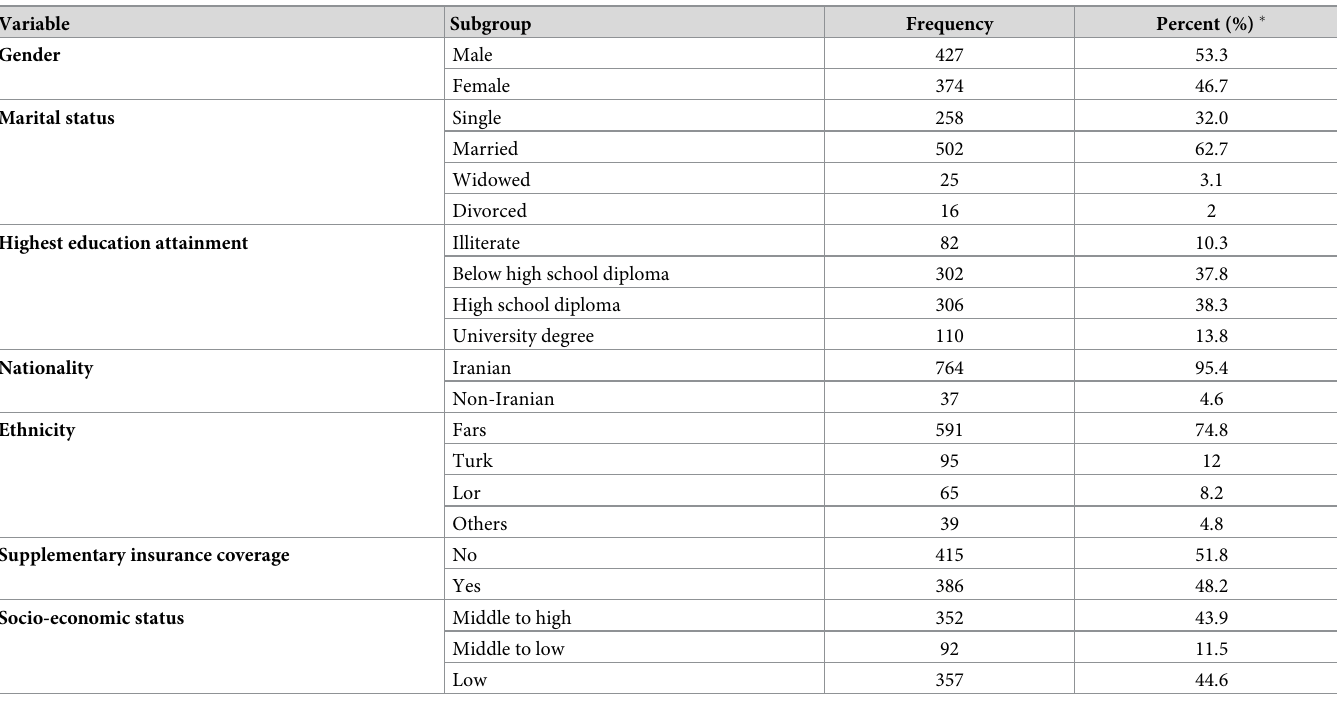
Table 1. Demographic characteristics of those reluctant toward vaccination in Shiraz city in 2022.